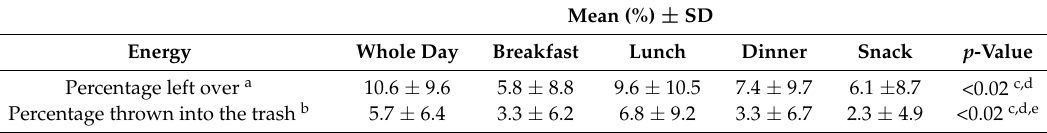
Table 2. Percentage energy left over and percentage of food thrown into the trash over the day in 86 girls nine to thirteen years living in O’ahu, Hawai’i who participated in the study and completed an acceptable mobile food